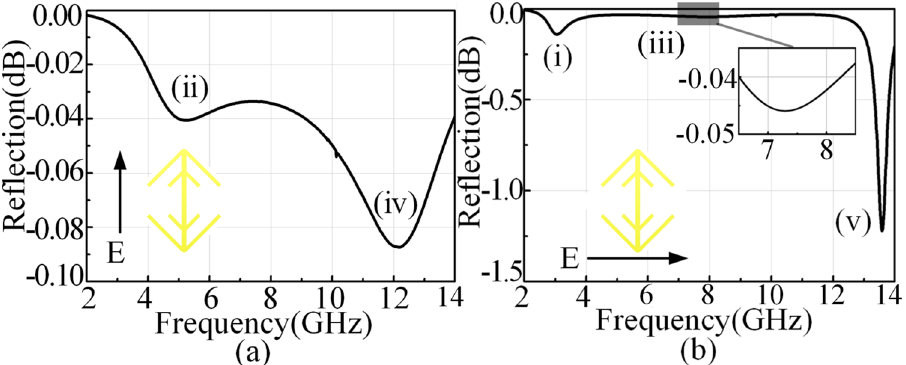
Figure 3. The five eigen-modes of unit 2 co-polarization reflections under normal incidence: v -polarized case (a) and u -polarized case (b)